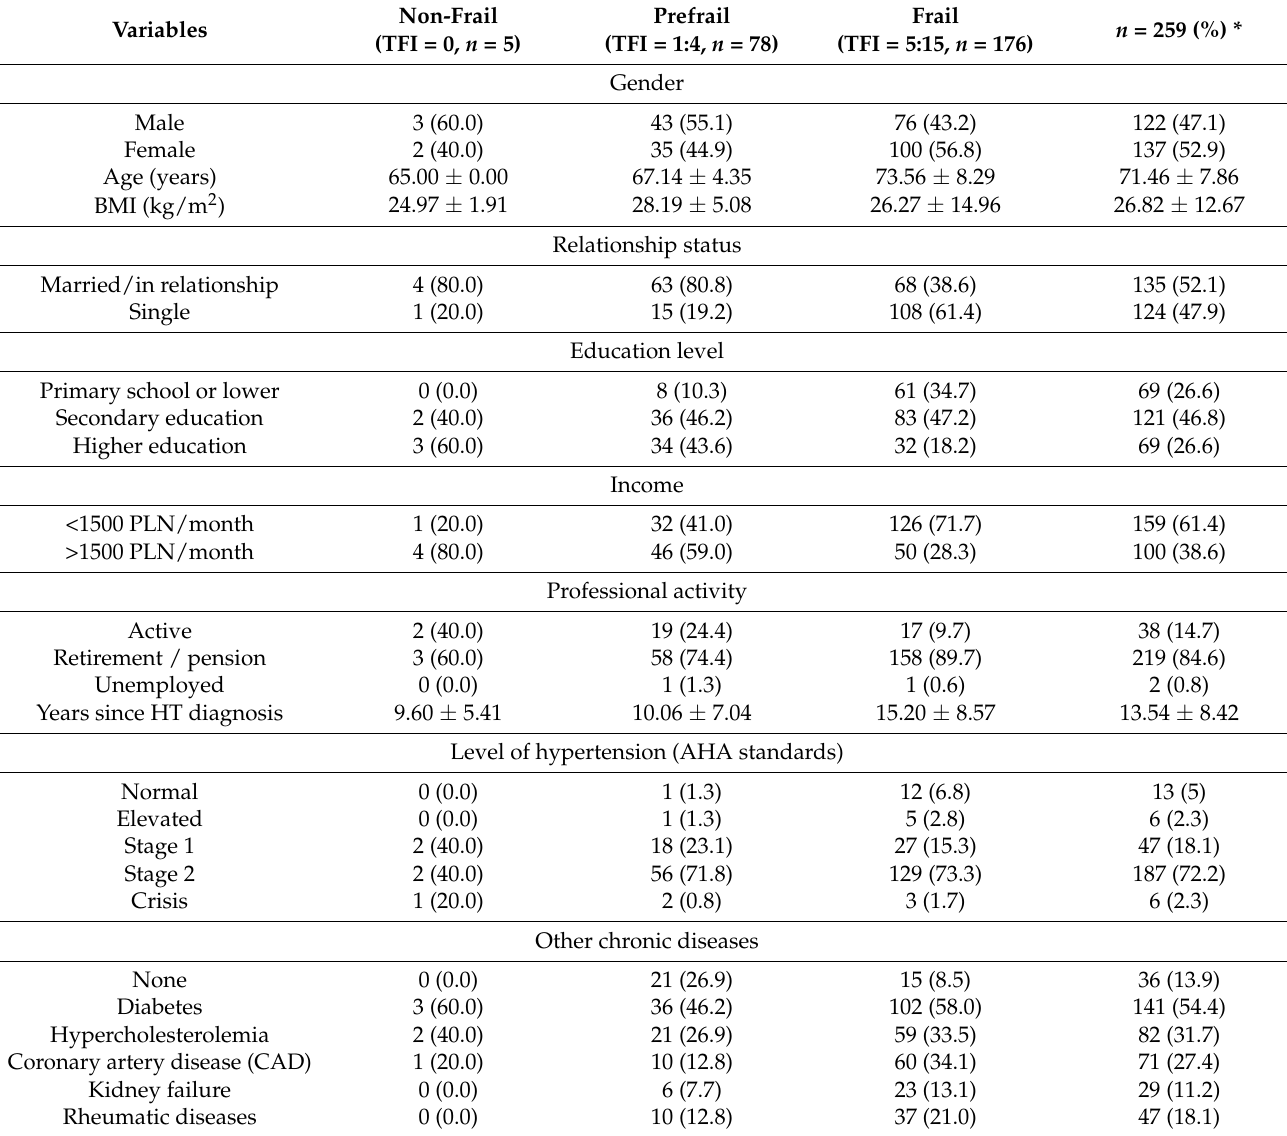
Table 1. Demographic and clinical characteristics of the total group of HBP patients ( n =